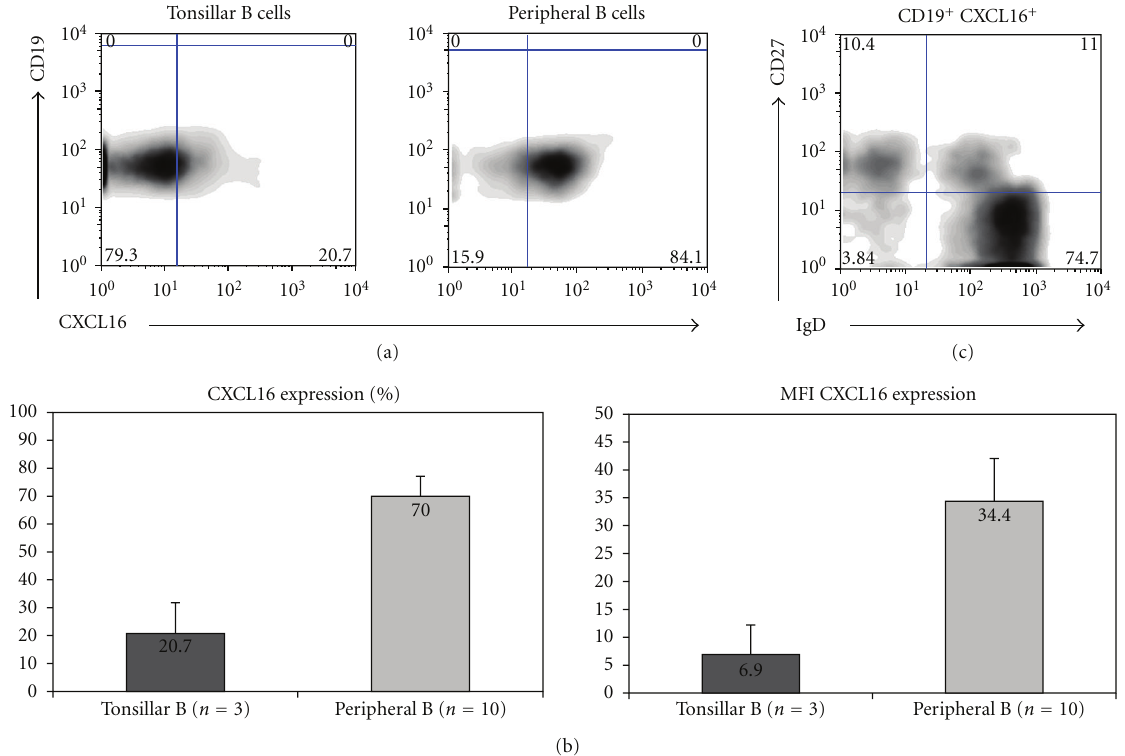
Figure 1: CXCL16 expression on primary B cells. (a) CXCL16 expression on tonsillar CD19 + B cells and peripheral CD19 + B cell subsets from healthy control (representative experiment). (b) Histogram-depicting percentage and mean fluorescence intensity of CXCL16 + CD19 + tonsillar B cells and peripheral B cells from healthy donors (mean of three di ff erent experiments for tonsillar B cells and ten healthy controls for peripheral B cells). (c) CXCL16 expression in the di ff erent maturative stages of peripheral B cells (representative of three di ff erent